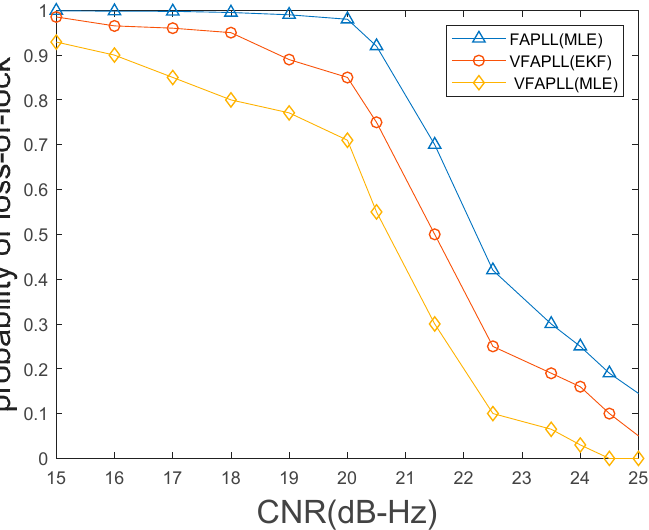
Figure 7. Loss-of-lock probability of the VFAPLL (MLE), VFAPLL (EKF) and FAPLL (MLE) at different CNRs.